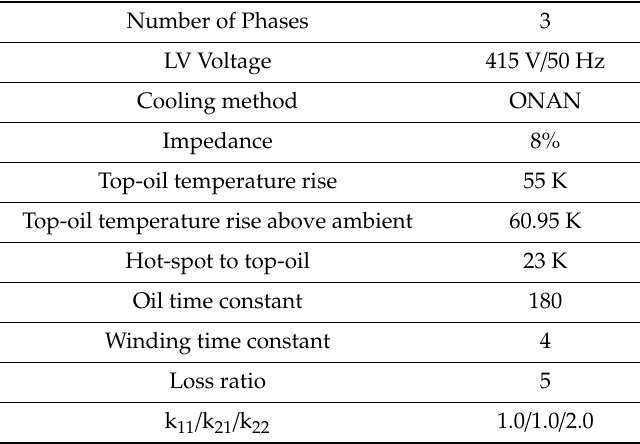
Table 3. Transformer parameters for 200